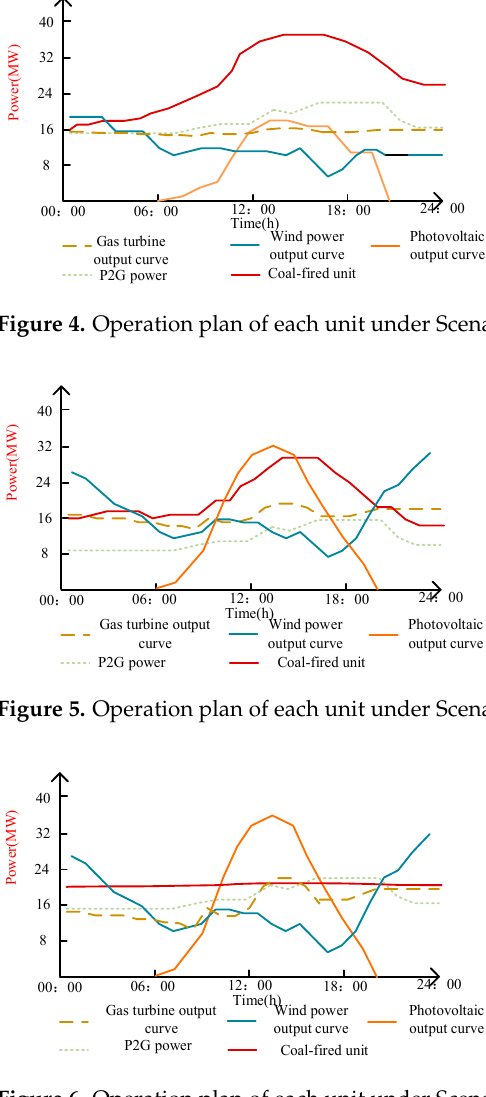
Figure 6. Operation plan of each unit under Scenario